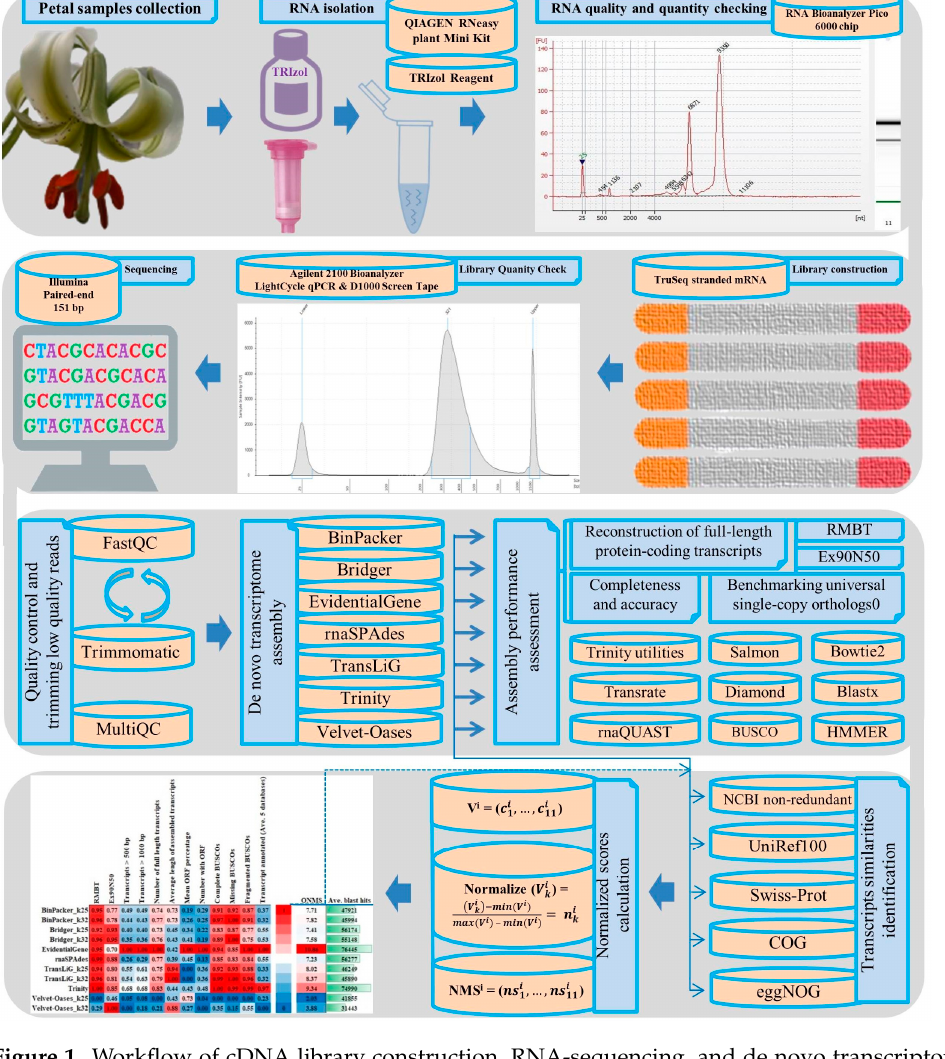
Figure 1. Workflow of cDNA library construction, RNA-sequencing, and de novo transcriptome analysis and